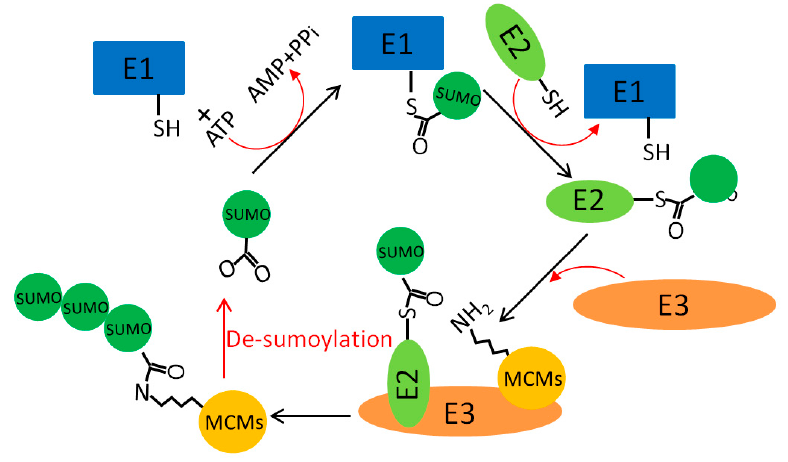
Figure 4. MCM modification by small ubiquitin-like modifier (SUMOylation).